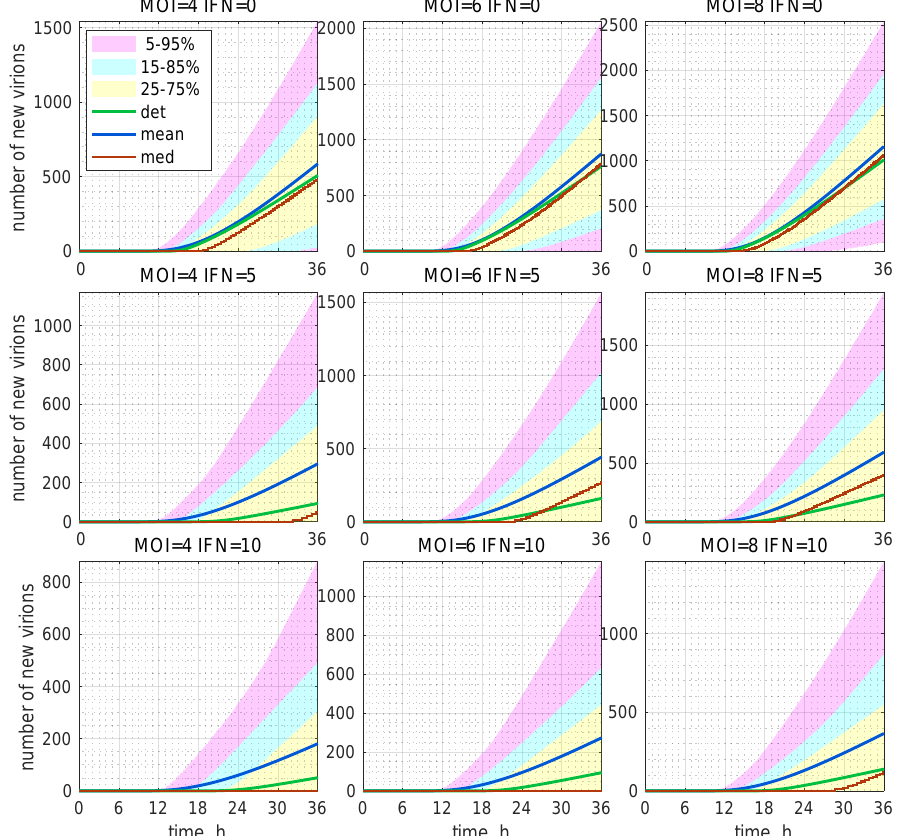
Figure 10. Evolution of the histograms for the total number of released virions during the devel- opment of an HIV-1 infection process. Time-varying confidence intervals for [V new ] computed for different MOI and [ IFN e ]( 0 ) indicated in the top of every plot, respectively, as V0 and IFN. Further- more, the deterministic solutions (det), mean values (mean), and medians (med) are plotted (colours for the patches and lines are explained in the legend). In the presence of extracellular IFN-I, i.e., 10 molecules per cell, the median is identically zero ( left bottom ). This means that, in more than 50% of cases, the stochastic replication process is extinct and new virions are not